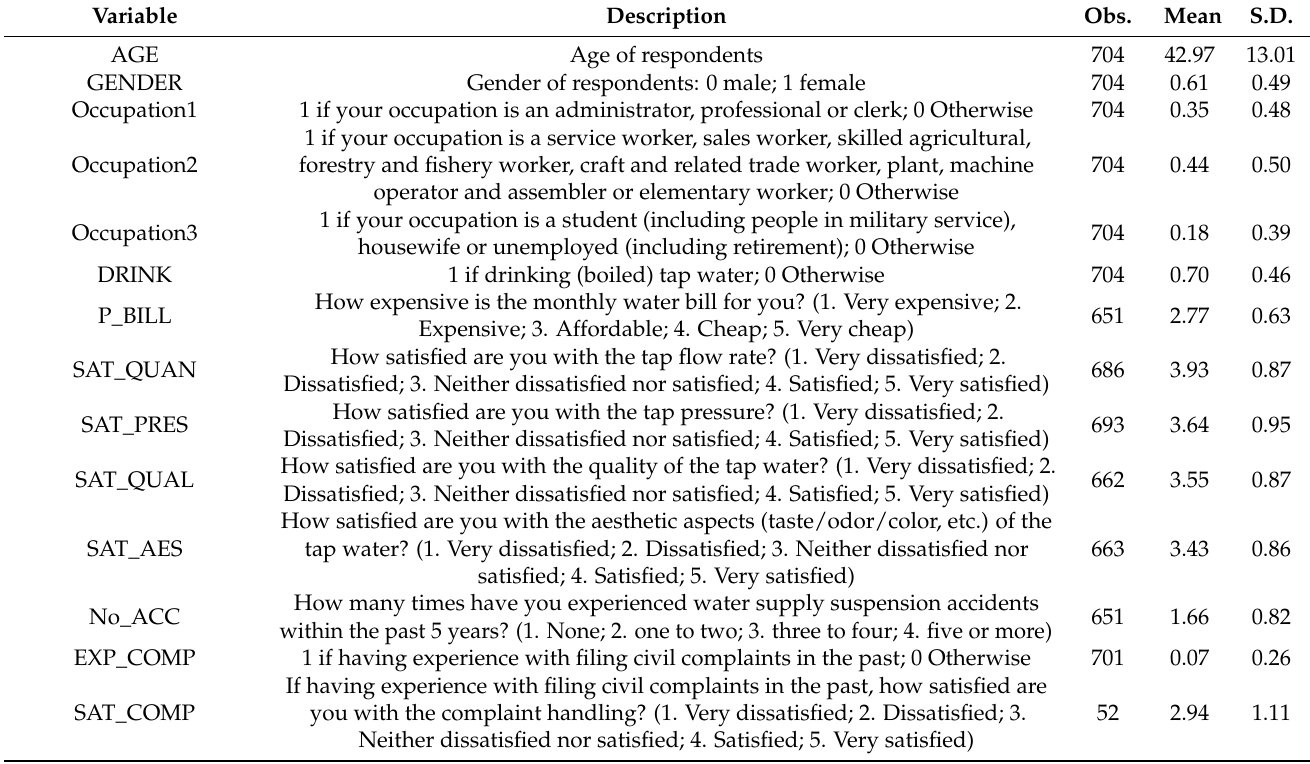
Table 2. Variable definition and descriptive